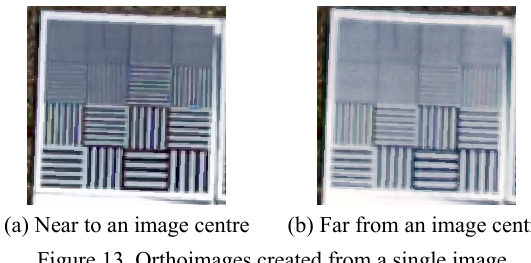
Figure 13. Orthoimages created from a single image Figure 14 shows a modulation transfer function (MTF) of ZEISS Loxia 2/50 (Carl Zeiss AG, 2017) that were utilized in image acquisition of Dataset M. Figure 14 indicate that the MTF of the lens depends on a radial distance on an image.